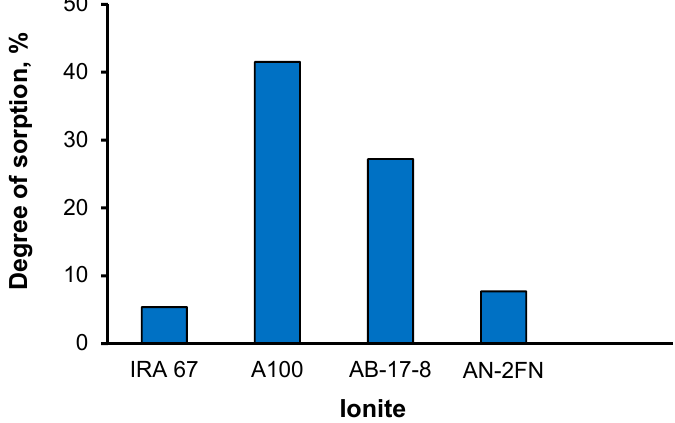
Figure 1. Dependence of niobium sorption degree on ion-exchange resin type.